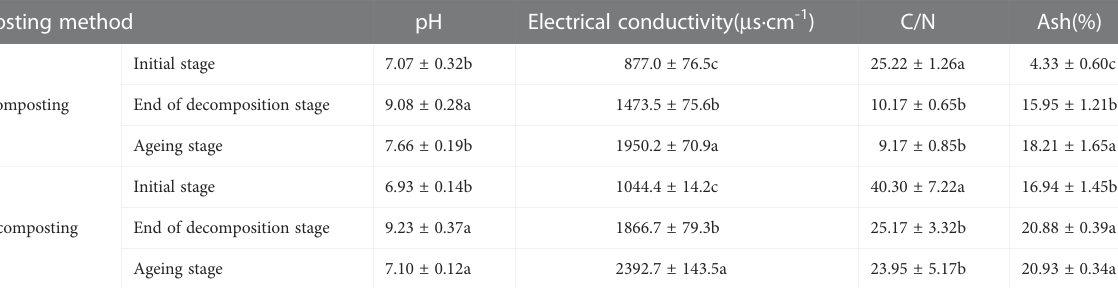
TABLE 1 The result of physico-chemical parameters. Composting